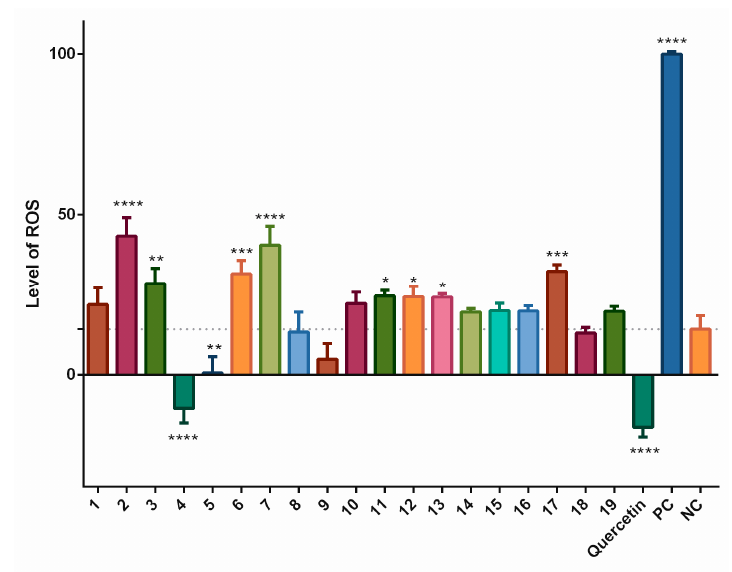
Figure 4. Antioxidant and pro-oxidant e ff ects of stilbenoids 1–19 alone (at a concentration of 2 µ M) on the formation of ROS after 2 h of incubation. In the THP-1-XBlue-CD14-MD2 cell model, the formation of ROS was triggered by stilbenoids alone; quercetin was used as the standard (2 µ M), pyocyanin alone served as the positive control (PC; 100 µ M), and the vehicle alone was the negative control (NC). * = p < 0.05; ** = p < 0.01; *** = p < 0.001; and **** = p < 0.0001.